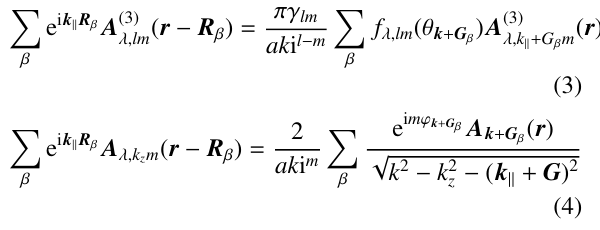
, 0 , cos π ) of negative helicity. The 3 3